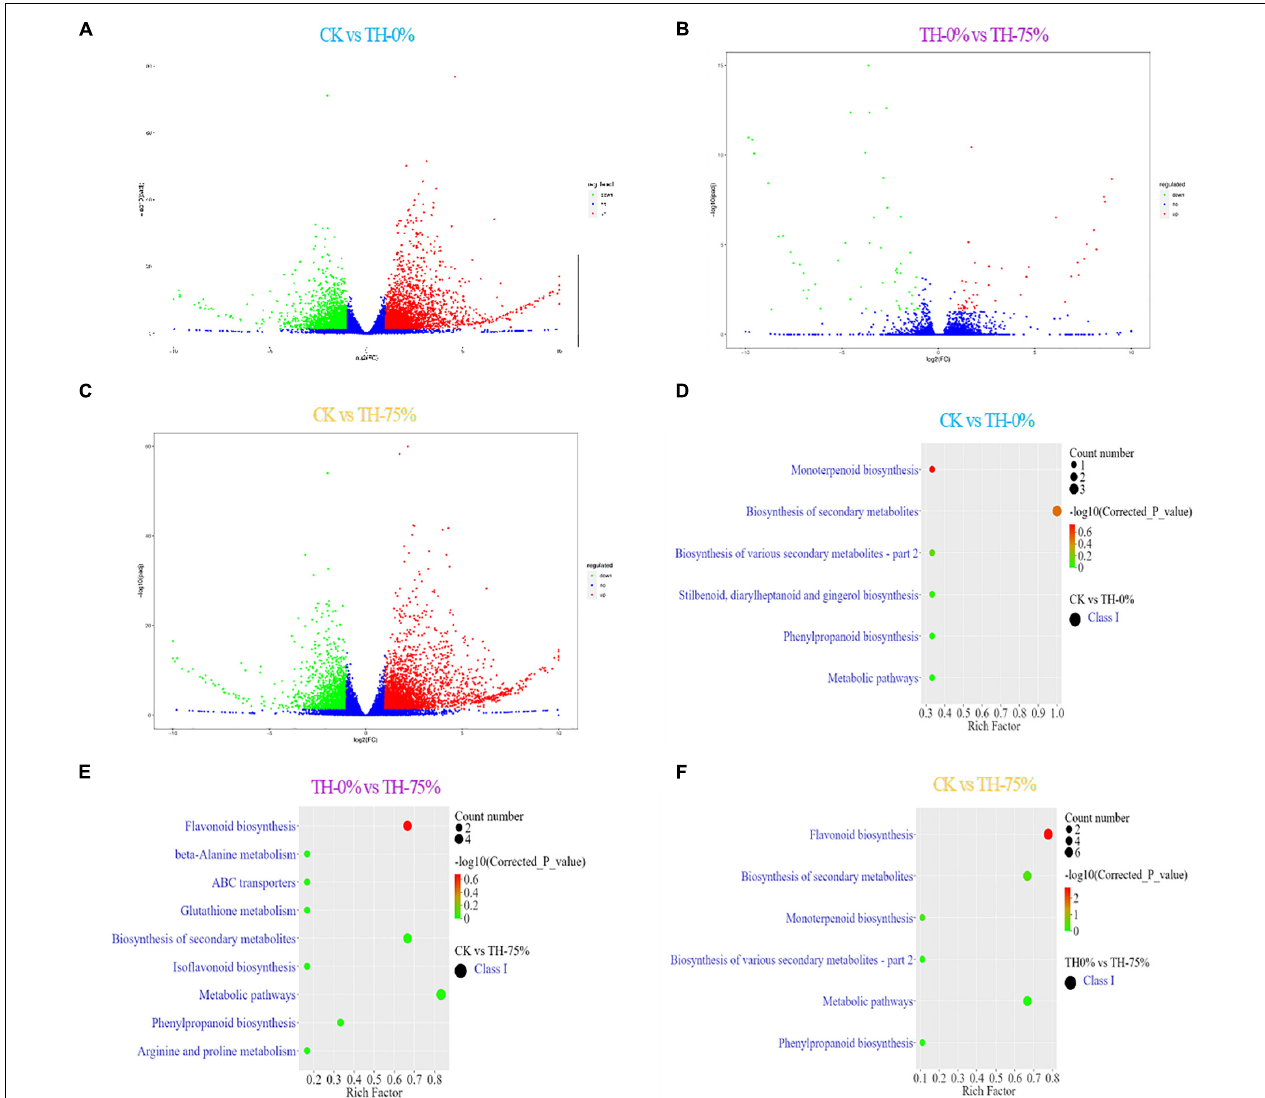
FIGURE 6 | Bar plot showing numbers of DEGs in CK vs TH-0% (A) , TH-0% vs TH-75% (B) , and CK vs TH-75% (C) groups. Bubble plots showing significantly enriched KEGG pathways ( P < 0.05). Top 10 pathways according to enrichment factor from DEGs in CK vs TH-0% (D) , TH-0% vs TH-75% (E) , and CK vs TH-75% (F) groups. The horizontal axis represents the differential expression multiple, and the vertical axis represents the degree of difference in gene meaning. The red dots indicate the upregulated expressed genes (Log 2 FC ≥ 2), the green dots indicate the downregulated expressed genes (Log 2 FC ≤ 0.5), and the blue dots indicate the non-significantly differentially expressed genes (0.5 < Log 2 FC <